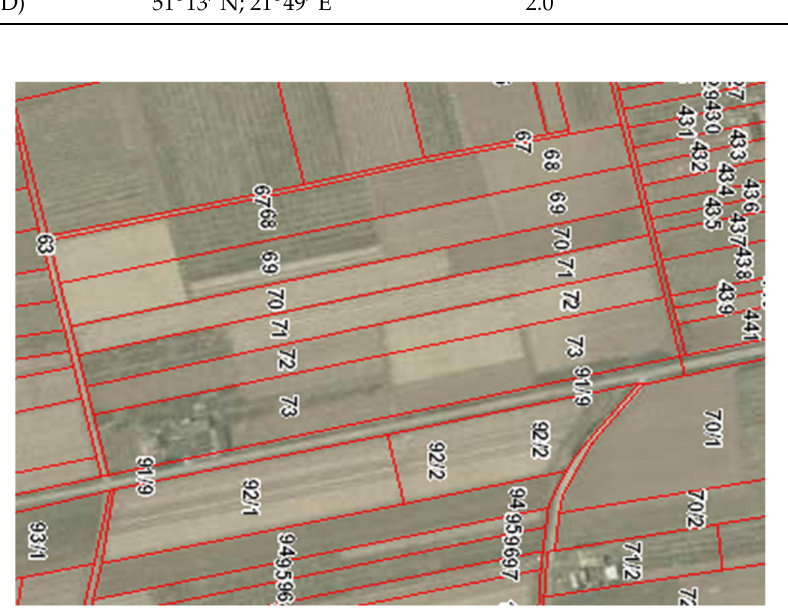
Figure 1. Plan of plots for hop cultivation on farm A (71, 72, 73).